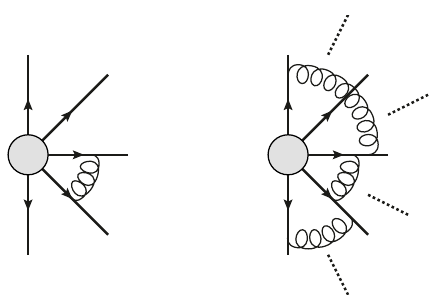
Figure 1 . Diagrammatic representation of single soft gluon exchanges between two legs as described by the soft anomalous dimension matrix (left), and all possible iterated exchanges as encoded in the evolution operator (right). Thick lines indicate the momenta of the (cid:12)nal state colour charges originating from the hard scattering indicated by the grey